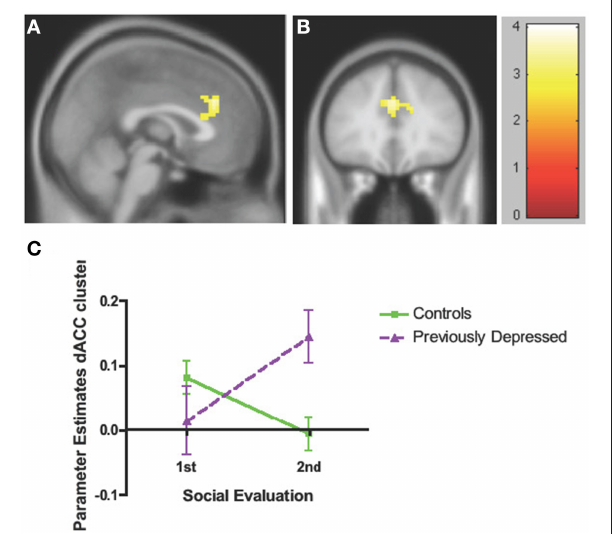
FIGURE 3 | Whole brain analyses of group × time interaction reflecting effect where neural activity increases over time in the previously depressed women but decreases in controls. (A) Sagittal view revealing a significant cluster in dorsal anterior cingulate cortex (dACC). (B) Coronal view of the same dACC cluster. (C) Parameter estimates extracted from the dACC cluster showing that within the control group activity within the dACC decreases, while in the previously depressed group, it increases. Note that extracted parameter estimates from this dACC cluster are taken from non-independent voxels and thus are used here simply to illustrate the observed effect at the whole brain level.